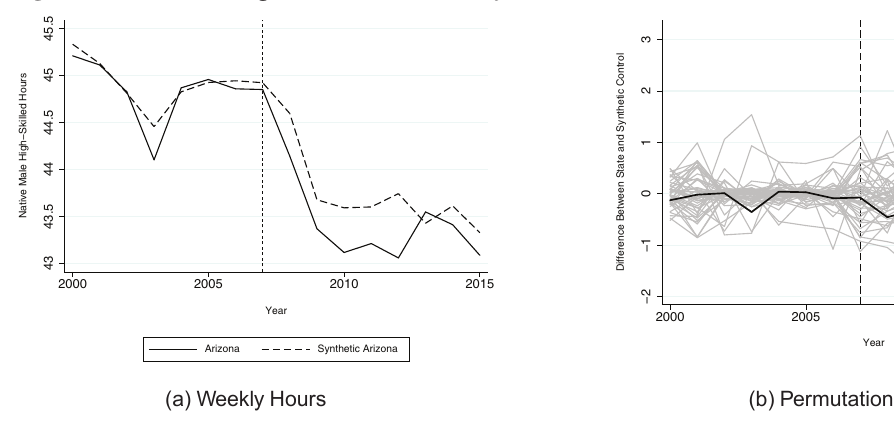
Native high-skilled male weekly hours (hours > 0)